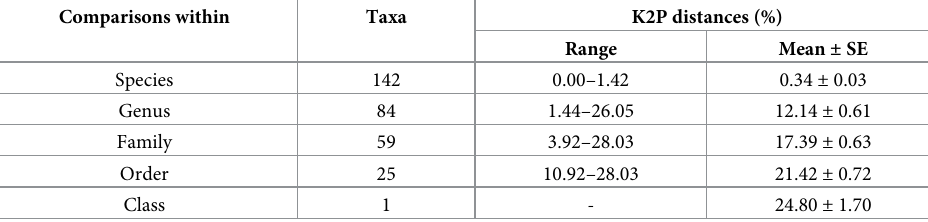
Table 2. Summary of genetic divergences (K2P percent) within various taxonomic levels based on 707 COI